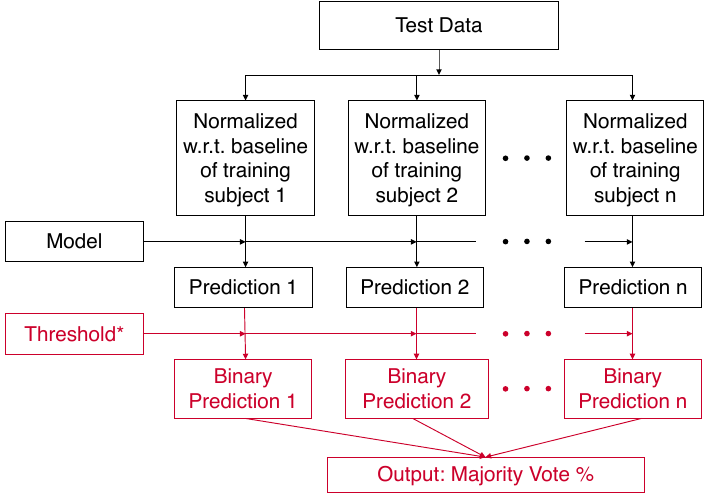
Figure 3. The predictions for the test data using the threshold chosen via optimization performed using the validation data as shown in Figure